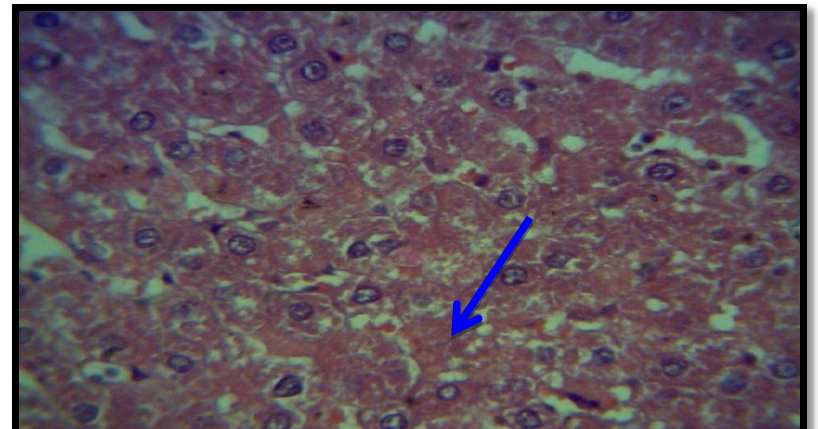
Figure (2):- Histological section in the liver of rat received 150 mg/kg B.W. of DPP suspension for 42 days, shows proliferation of kupffer cell ( ) and no nuclear lesion (H and E, x 40).